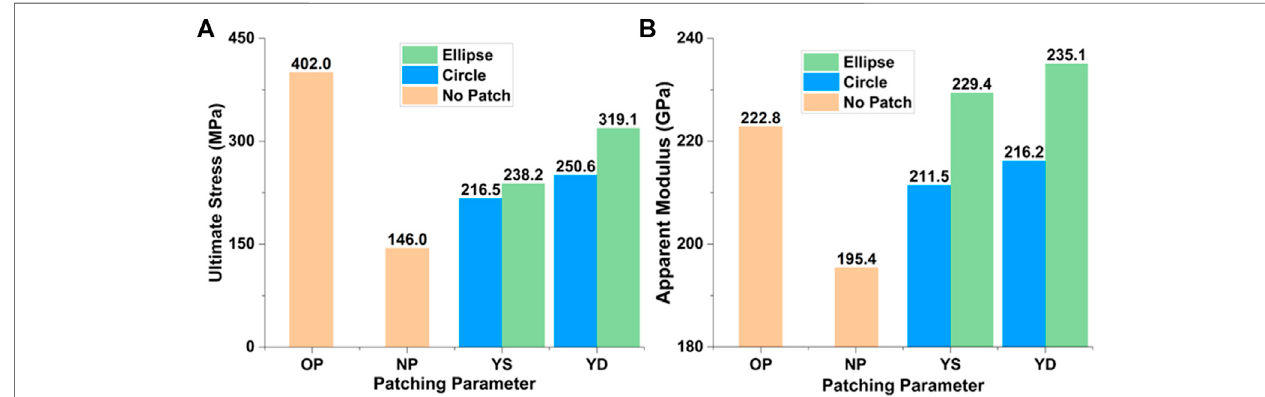
FIGURE 15 | Study on patch shape: (A) comparison of ultimate tensile stress; (B) comparison of apparent moduli. The abbreviations YS and YD represent the drilled sample with TFP SSR and TFP DSR, respectively.